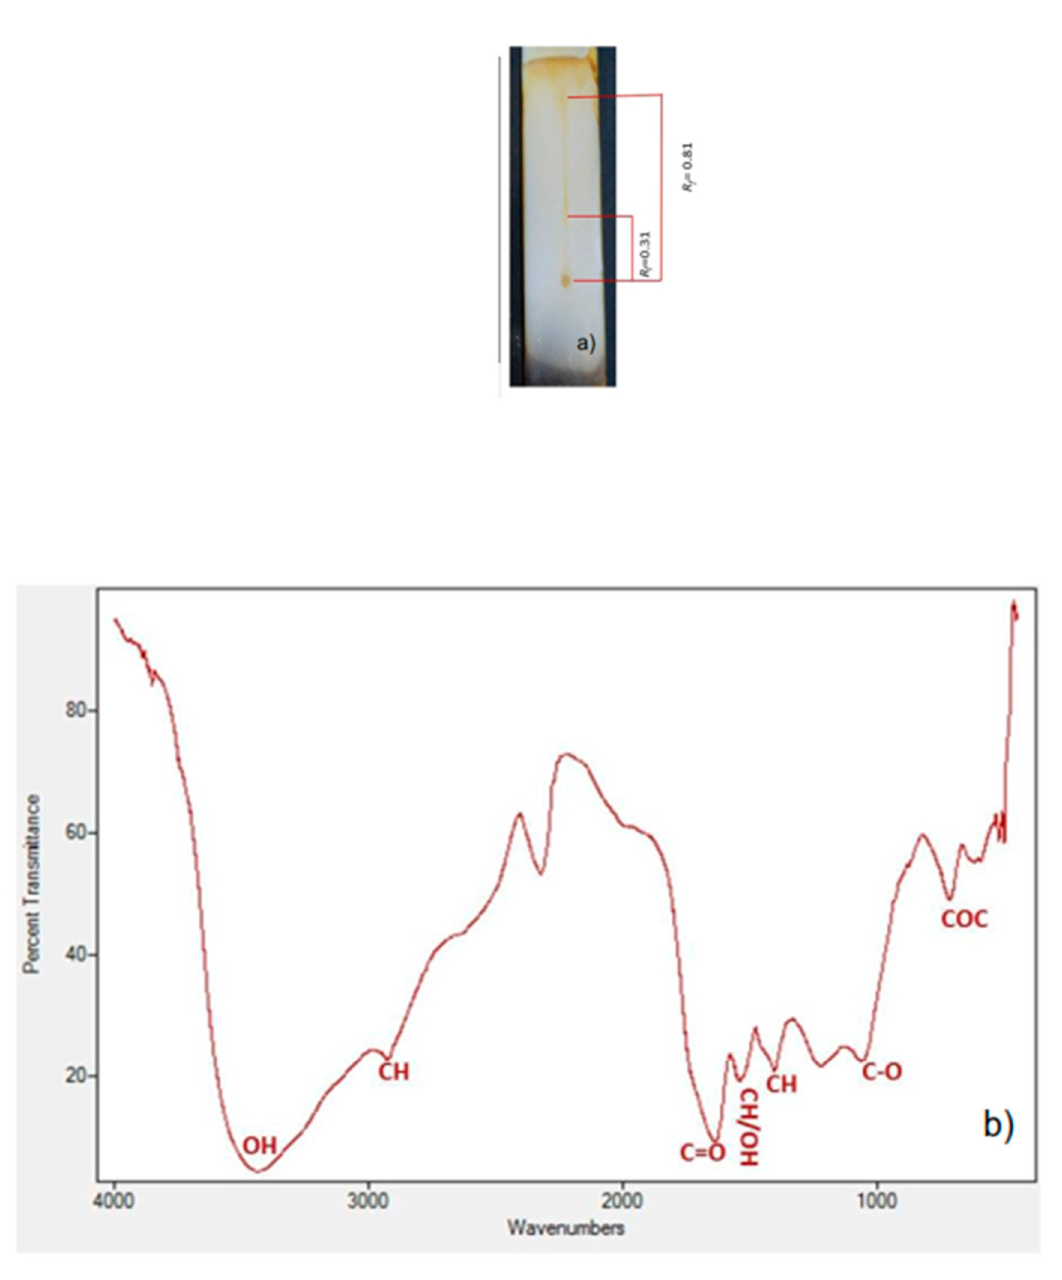
Figure 3. The thin-layer chromatographic slide proving mono- and di-rhamnolipid presence in the extracted mixture ( a ) and Fourier transform infrared spectroscopic (FT-IR) spectra confirming the presence of a rhamnolipid-type biosurfactant ( b ). Rf –retention factor (0.31 for di-rhamnolipid and 0.81 for mono-rhamnolipid).